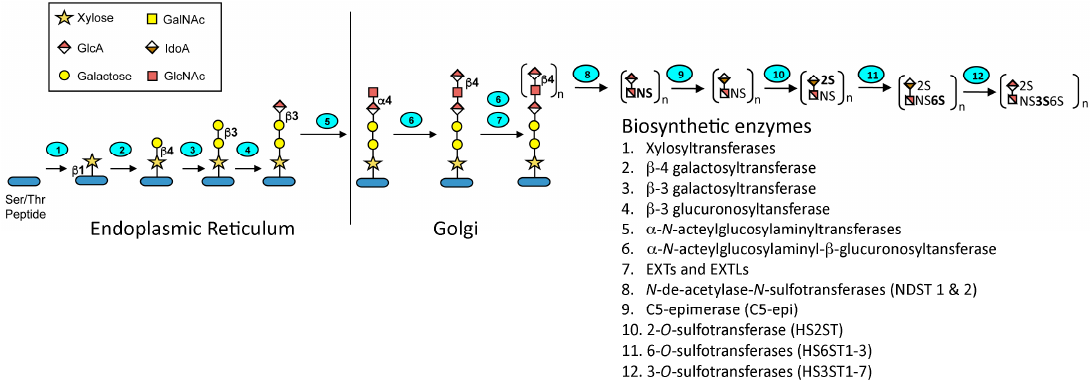
Figure 2. Heparin biosynthesis. The glycosaminoglycan-protein linkage region is first formed under the action of glycosyltransferases. The repeating disaccharide units are then elongated by GlcA and GlcNAc transferases. Chain modifications including N -deacetylation and N -sulfonation, O -sulfonations, and epimerization then occur under the actions of the specified enzymes. Monosaccharide symbols in this figure follow the SNFG (Symbol Nomenclature for Glycans) system [15]